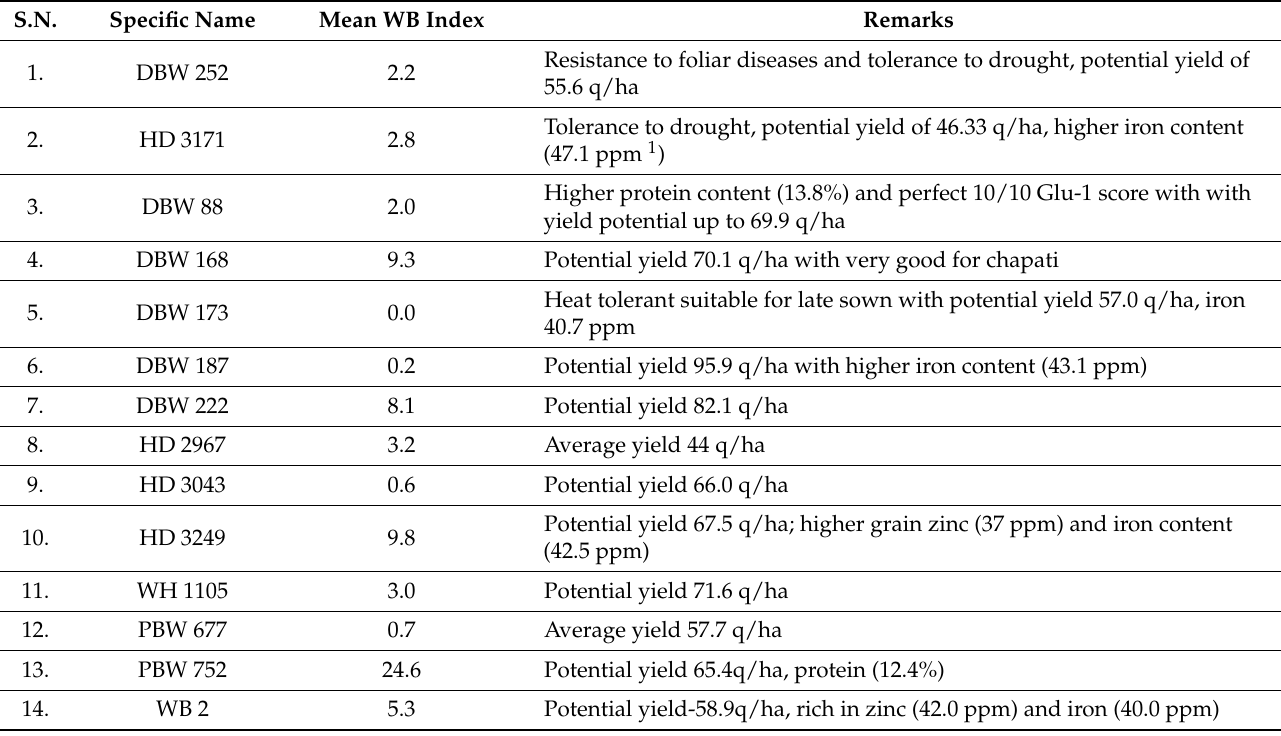
Table 2. List of 2NS positive varieties of wheat from India recommended for commercial cultivation.